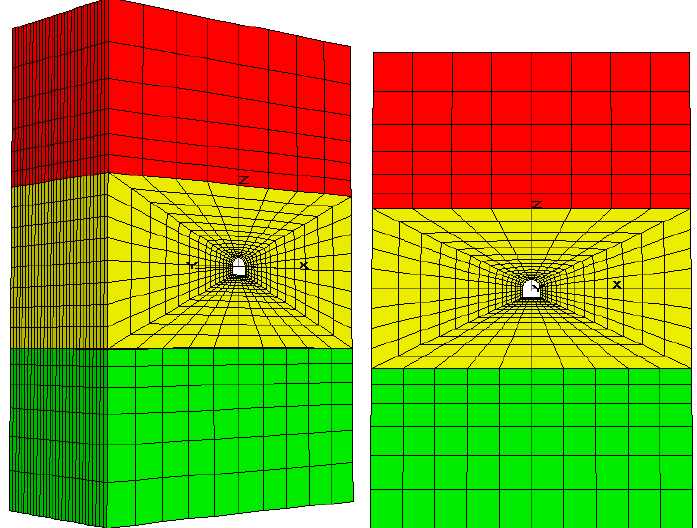
Figure 7. The three-dimensional numerical model based on